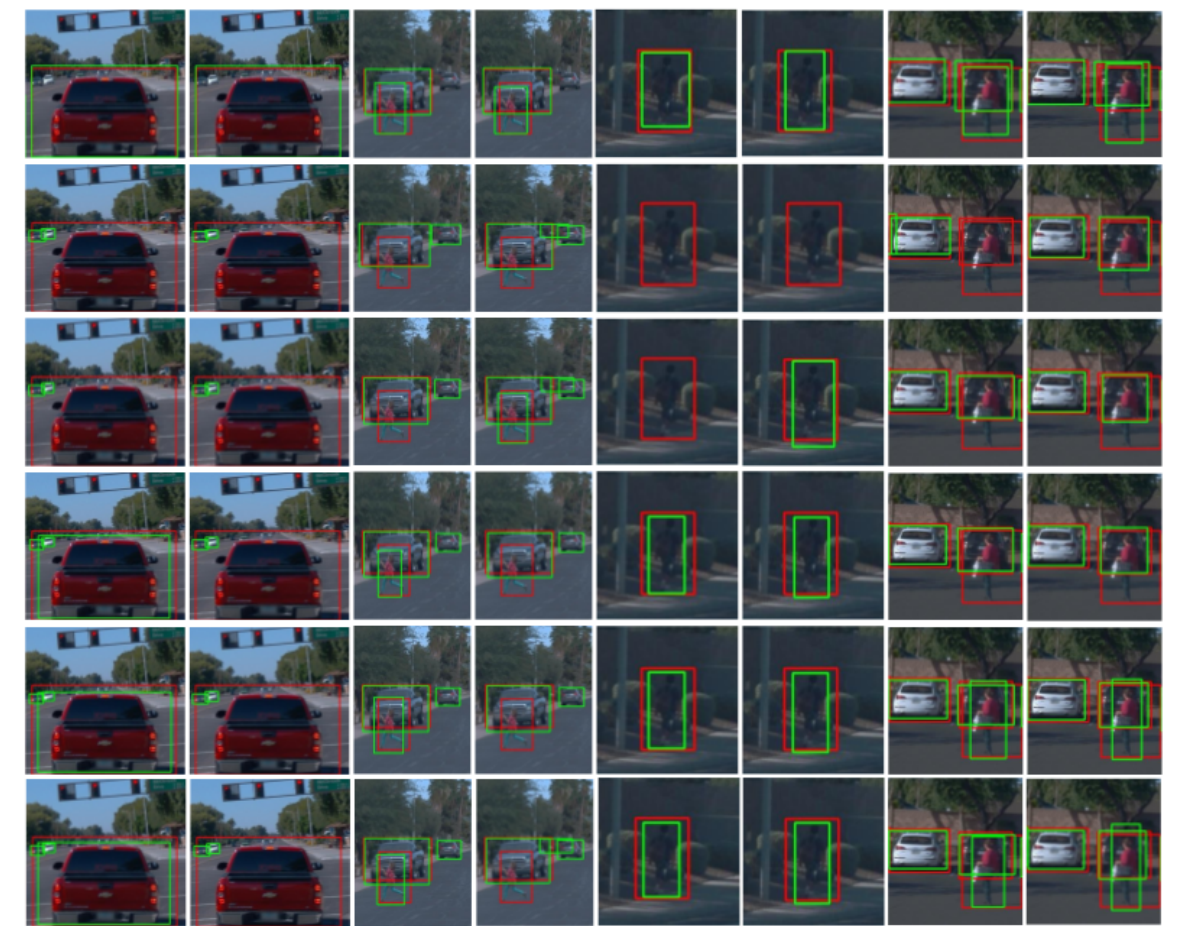
Figure 7. Qualitative results similar to those in Figure 6, but testing on W tt , co-training from V in the multi-modal case (left column of each block), and V G in the single-modal case (right column of each block). Since, in these examples, the two W co-training modalities are based on different (labeled) data, the first row of each block shows the respective UB results, i.e., those based on training with W tr and either with V (left image: Target + Source) or V G (right image: Target + ASource). W The second row of each block shows the respective results we would obtain without leveraging the unlabeled data, i.e., the LBs based on training with V (left image: Source) or V G (right image: ASource). As in Figure 6, the rest of the rows of W each block correspond to stopping co-training at cycles 1, 10, 20, and